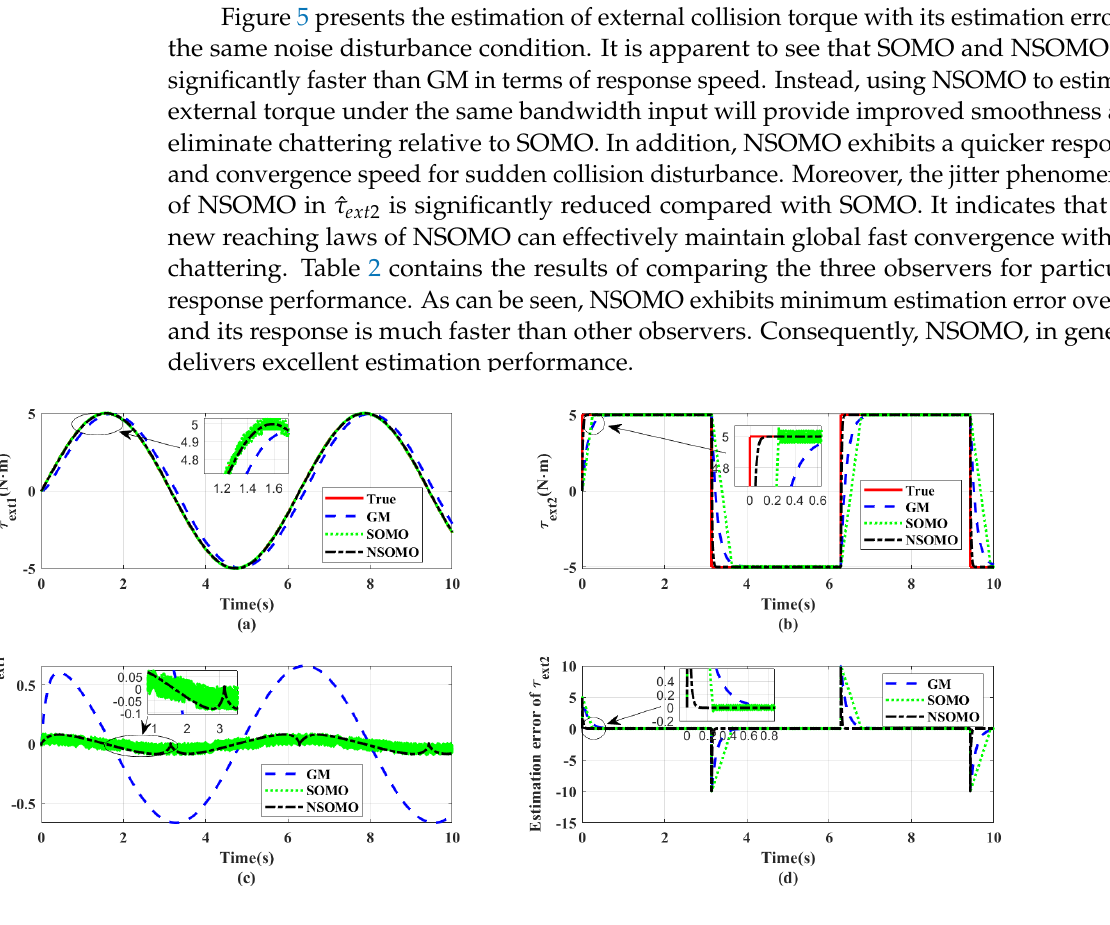
Figure 5. Comparison of external collision torque estimates for three observers. ( a , b ) Exterior torque estimation comparison for respective joints. ( c , d ) External torque estimation error comparison of the respective joints. These three observers are all based on same observer bandwidth and trajectory